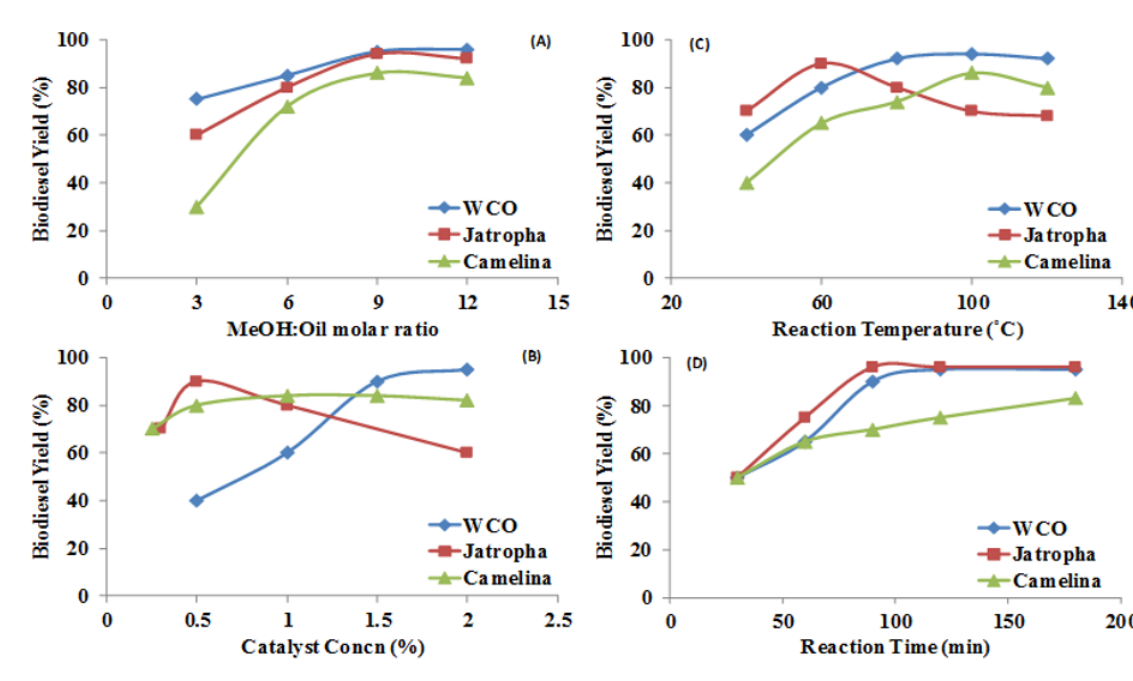
Figure 3. Process optimization for waste cooking, Jatropha Curcas and Camelina Sativa oils